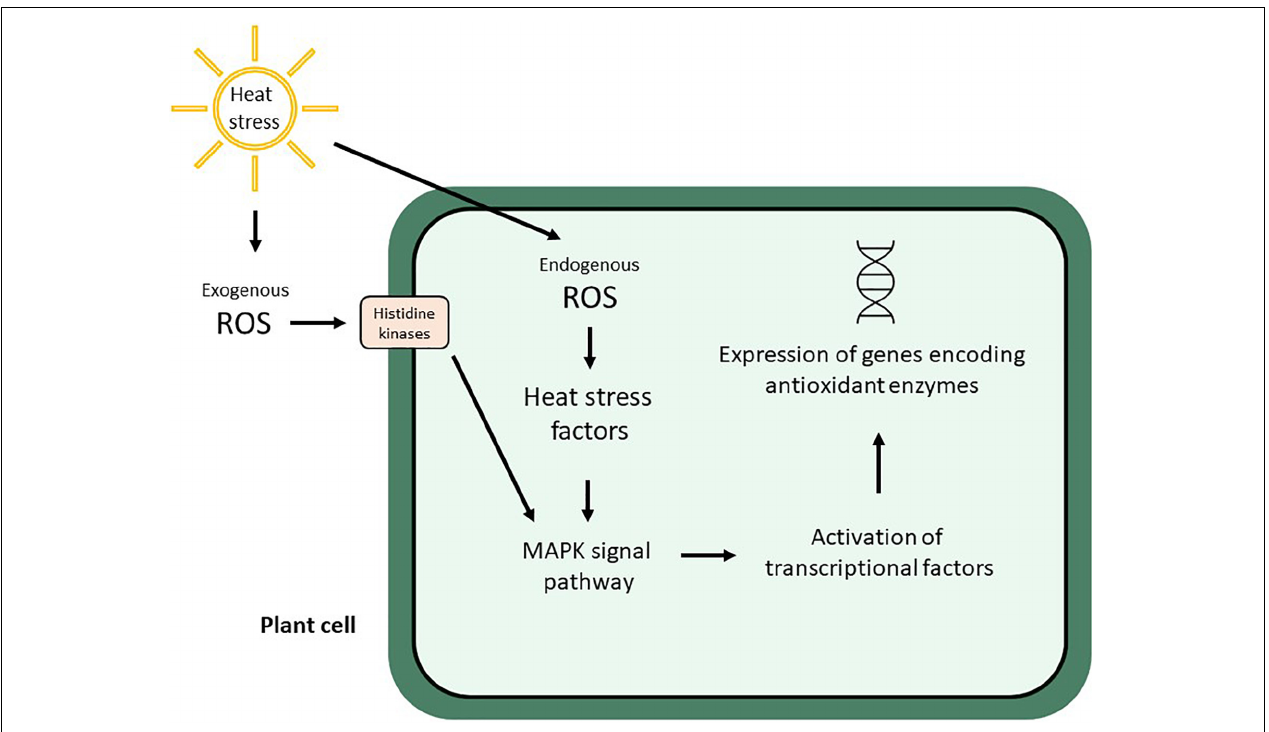
FIGURE 1 | Plant cell response to exogenous and endogenous ROS production stimulated by heat stress (modified from Qu et al.,